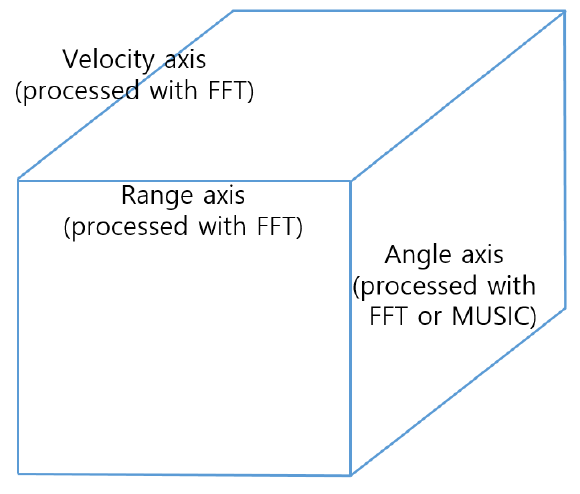
Figure 1. Cube expression of processed radar